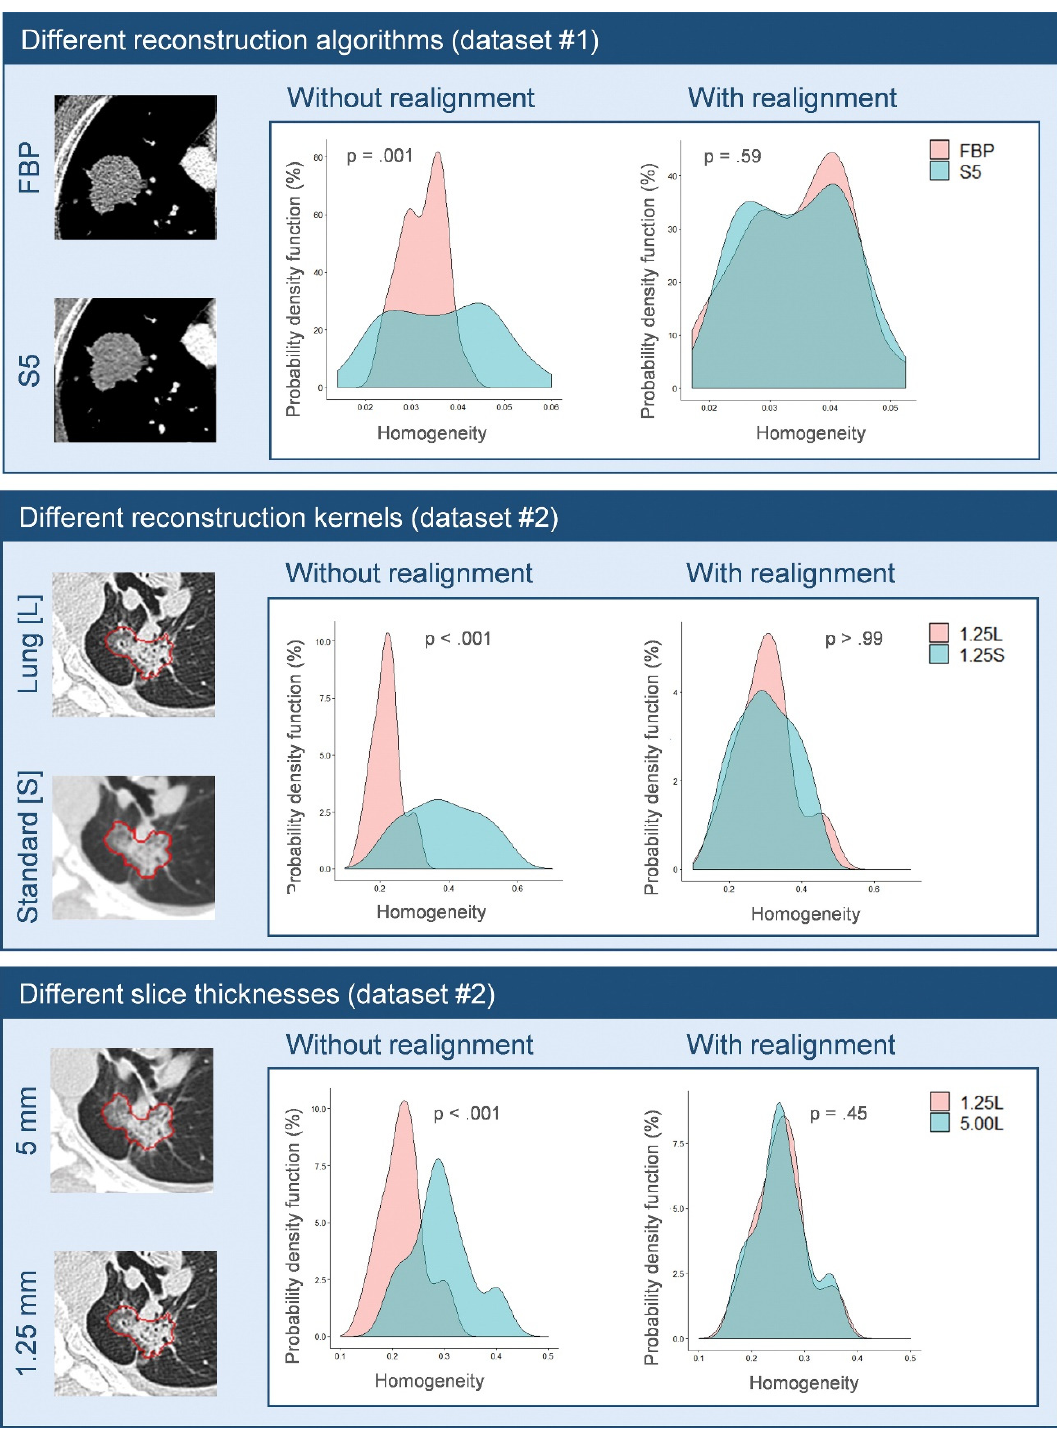
Figure 7. Probability density function of homogeneity before and after applying ComBat for realignment between different CT reconstruction algorithms, reconstruction kernels and slice thicknesses. FBP: filtered back-projection. Figure reproduced from [170]. Figure reproduced with copyright permission from The Radiological Society of North America.